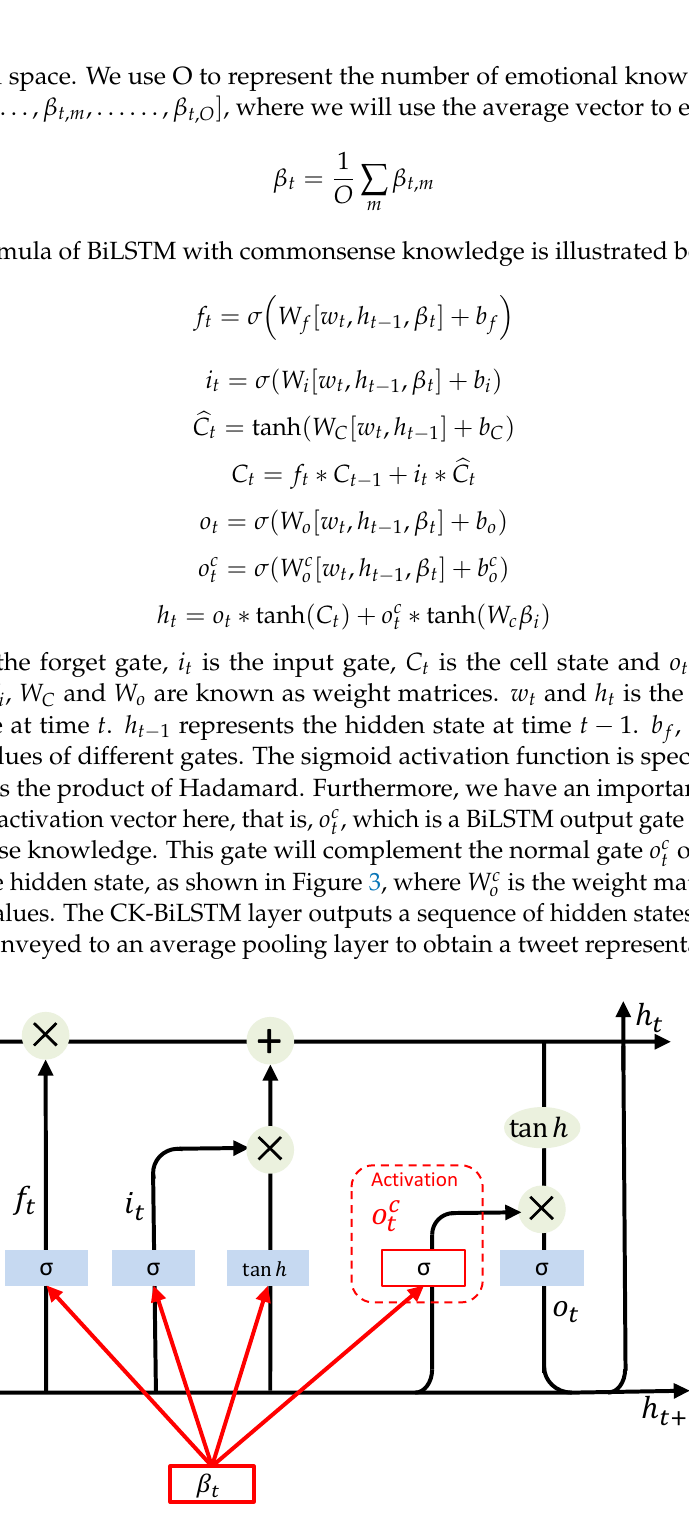
Figure 3. The structure of the commonsense knowledge BiLSTM